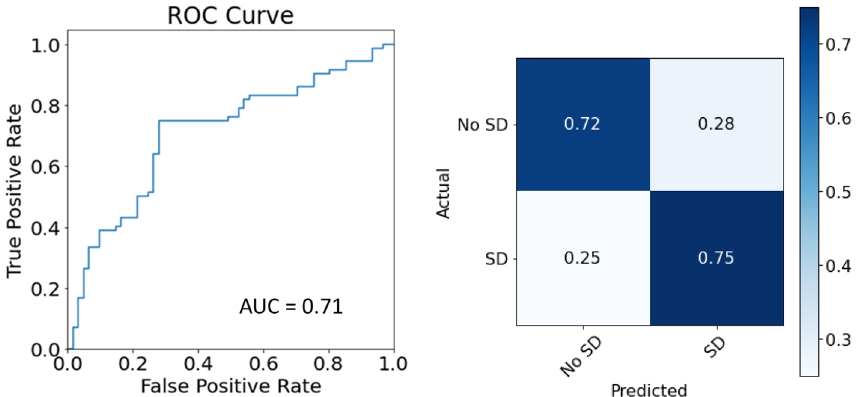
Sex Diagnoses n with SD (%) No MDD or ADHD 14 28.6 Male ADHD 19 15.8 n = 51, 37.3% with SD MDD 15 80.0 M age (Std) = 39.7 (13.2) MDD and ADHD 0.0 No MDD or ADHD 23 Female n = 82, 64.6% with SD M age (Std) = 35.8 (11.8)